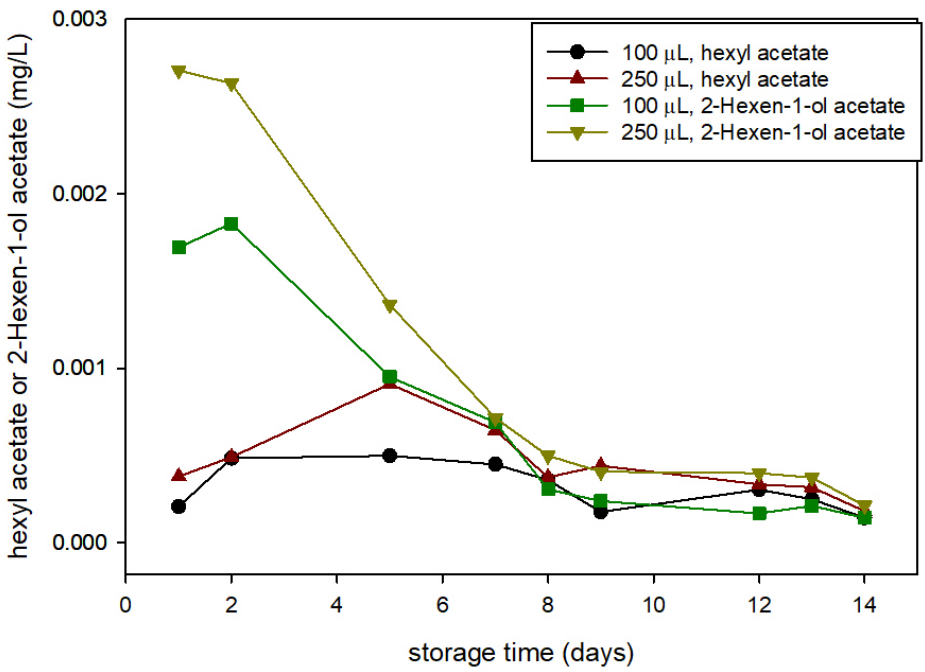
Figure 4. Concentration of hexyl acetate (HxAc) and 2-hexen-1-ol acetate (HxnAc) in head space (HS) of strawberries in active packaging with different quantities of trans-2-hexenal (HXAL) added (100 and 250 µL).